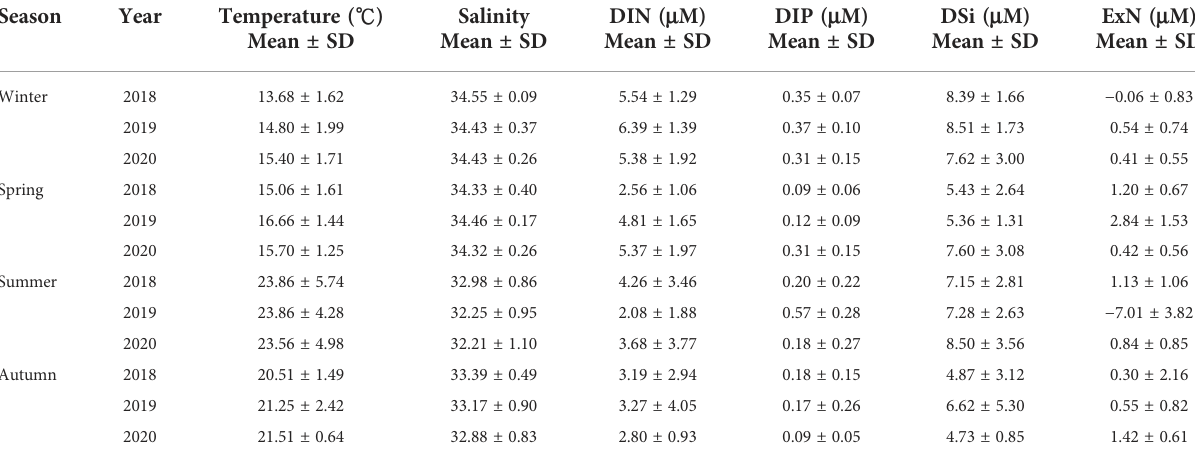
TABLE 3 Temperature, salinity, and dissolved inorganic nutrient concentrations at the euphotic depths (100%, 30%, and 1%) of the water column in the SCWK, 2018 –